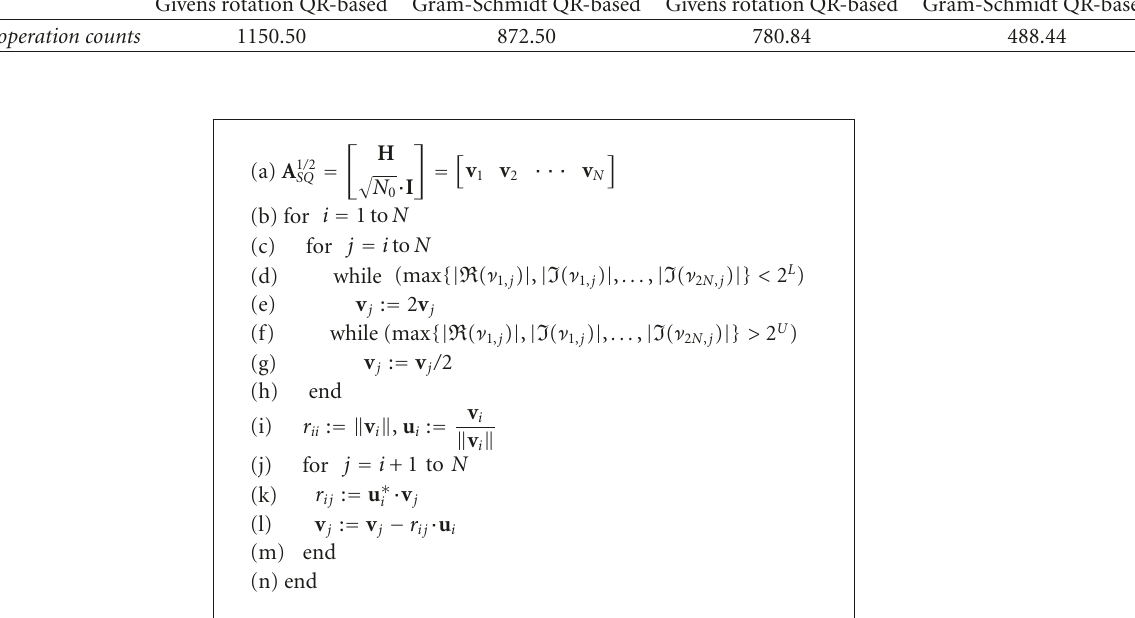
Table 3: Adjusted operation counts for computing W MMSE and Squared MMSE